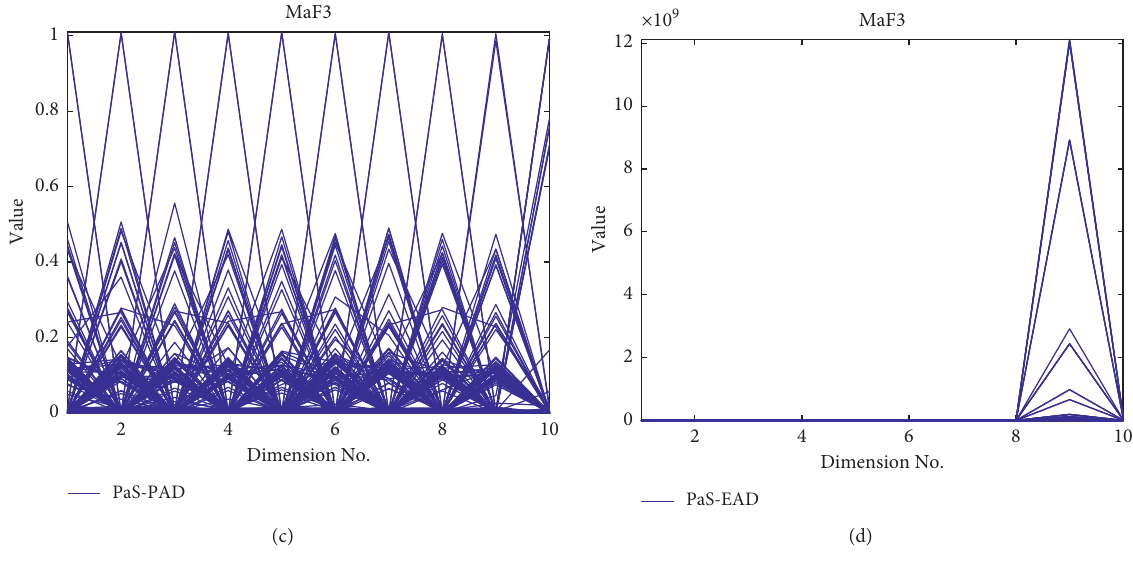
Figure 6: Visualization of PF approximation by four algorithms on the 10-objective MaF3: (a) MOEA/D-PaS, (b) PaS-LAD, (c) PaS-PAD, and (d) PaS-EAD. Table 6: Runtimes (mean/std) comparison results on